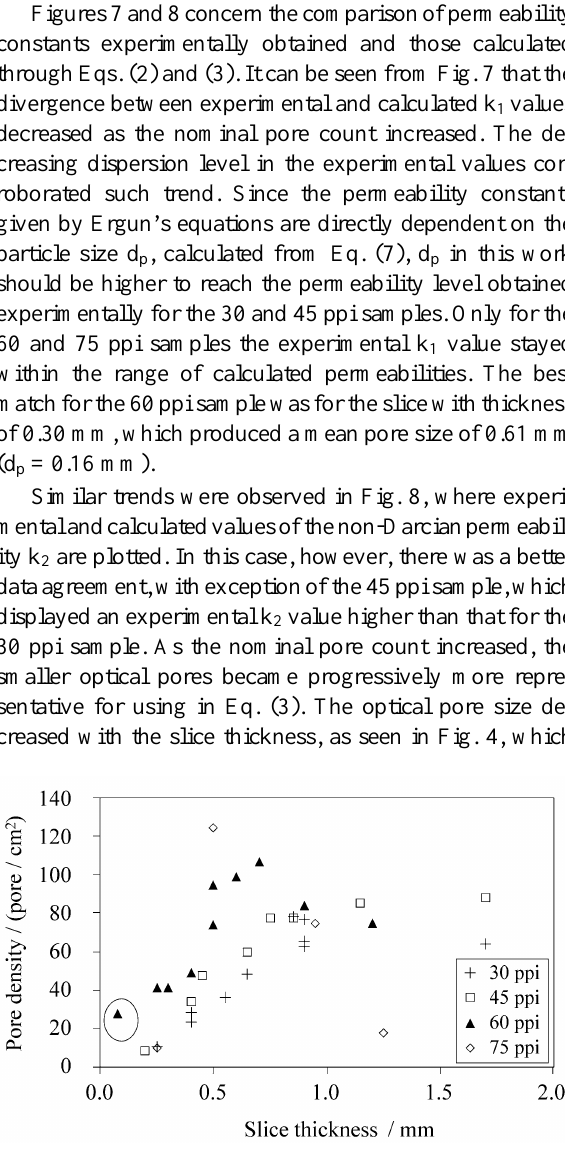
Figure 6. Influence of slice thickness on the pore density of SiC-Al 2 O 3 ceramic foams with 30 to 75 ppi. Circled symbol refers to the CT-image